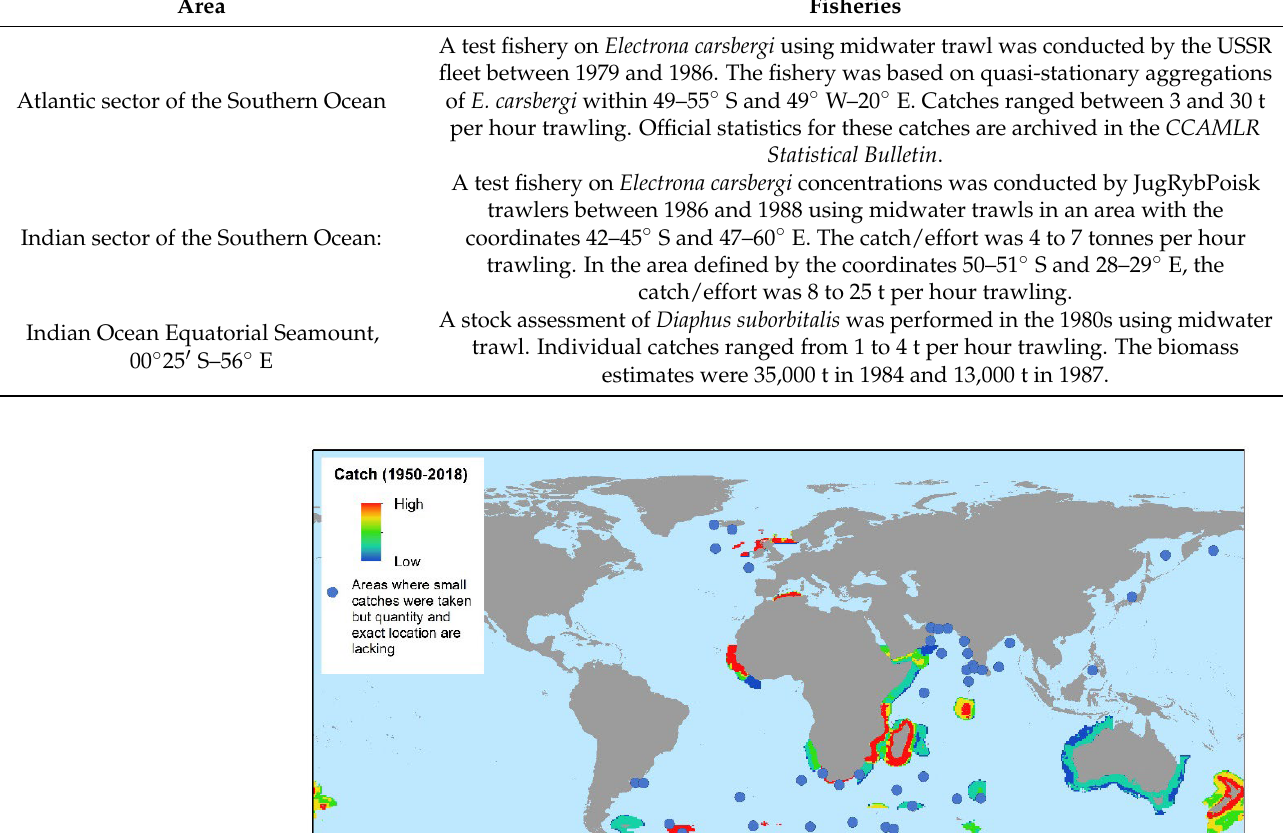
Table 5. Results of some test and exploratory mesopelagic fisheries by the ex-USSR (L. K. Pshenichnov, pers. obs.). Area